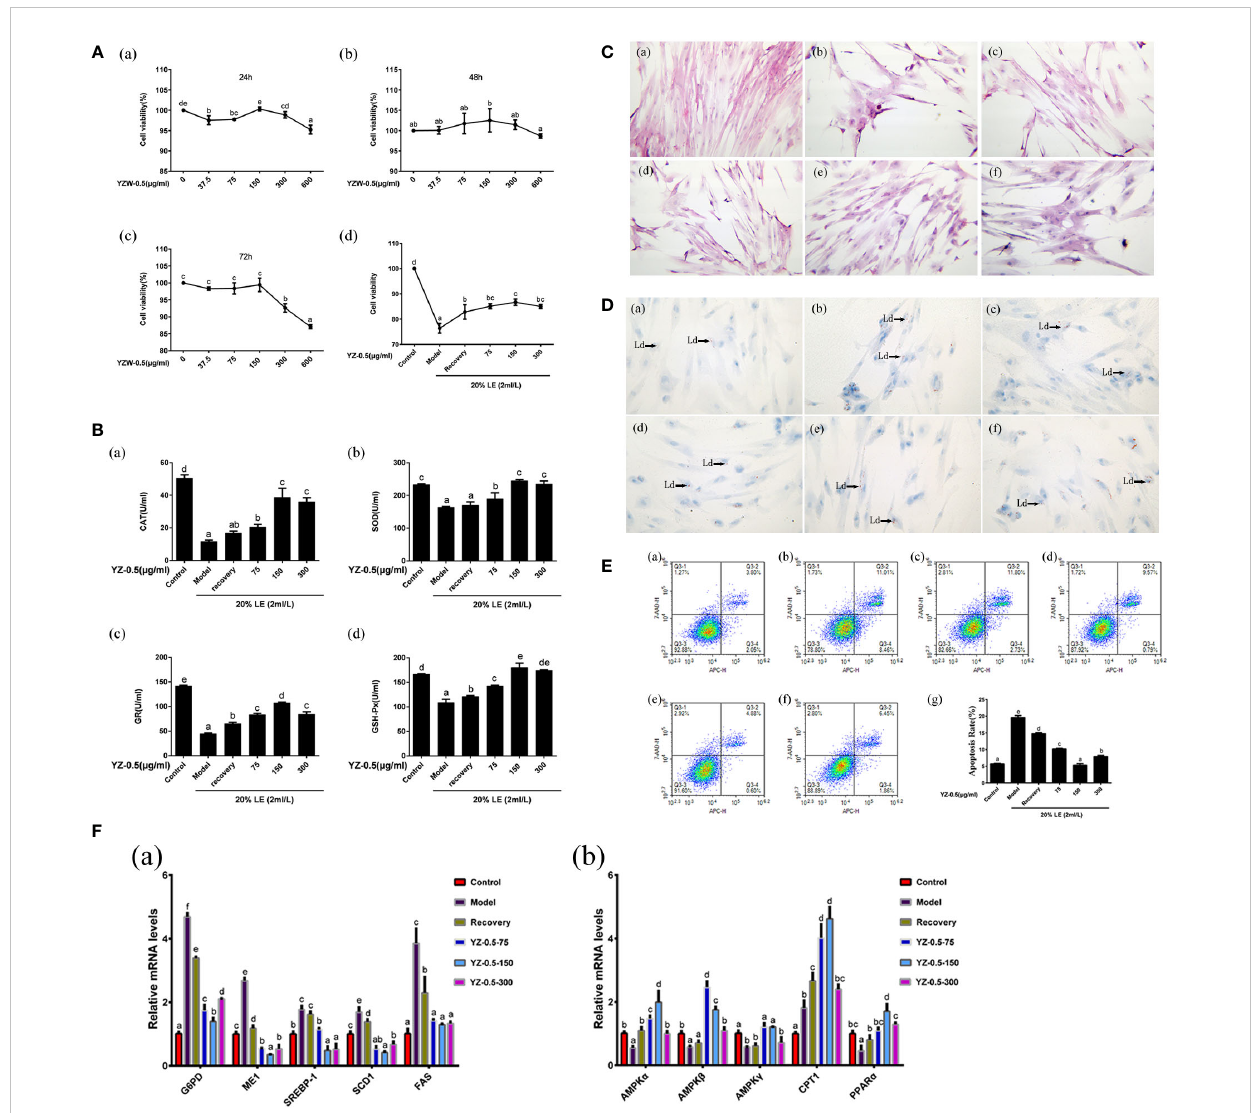
FIGURE 4 Effect of YZ0.5-A on lipid accumulation and antioxidant activity of primary hepatocytes in vitro . (A) Cell viability. (B) The levels of antioxidant enzymes. (C) Morphological changes (100×). (a) Control: hepatocytes neither treated with 20% lipid emulsion (LE) (2 ml/L) nor YZ-0.5A; (b) Model: hepatocytes treated with 20% LE (2 ml/L) alone for 72h; (c) Recovery group: hepatocytes treated with 20% LE (2 ml/L) for 48h, then incubated with normal medium for 24 h; (d) YZ-0.5A (75 m g/ml) + 20% LE (2 ml/L); (e) YZ-0.5A (150 m g/ml) + 20% LE (2 ml/L); (f) YZ-0.5A (300 m g/ml) + 20% LE (2 ml/L); (D) Histochemistry (Oil Red O staining, 400×; Ld: lipid droplet.) (a) Control: hepatocytes neither treated with 20% lipid emulsion (LE) (2 ml/L) nor YZ-0.5A; (b) Model: hepatocytes treated with 20% LE (2 ml/L) alone for 72h; (c) Recovery group: hepatocytes treated with 20% LE (2 ml/L)